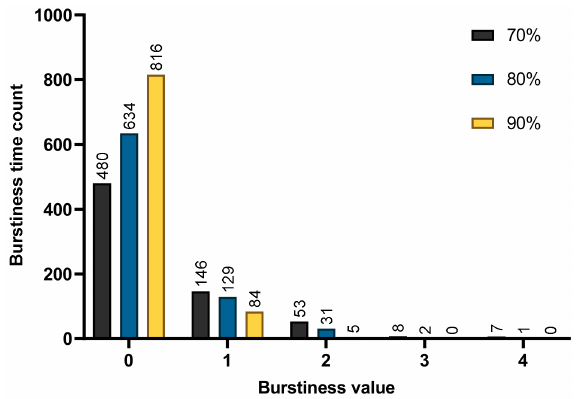
Figure 2. The distribution of Burstiness compared with link Packet Reception Rate